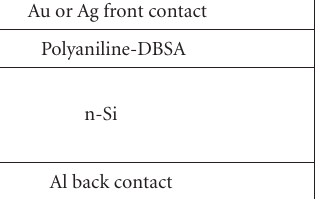
Figure 1: Schematic of Al/n-Si/polyaniline-DBSA/Au or Ag hetero- junction solar cell.